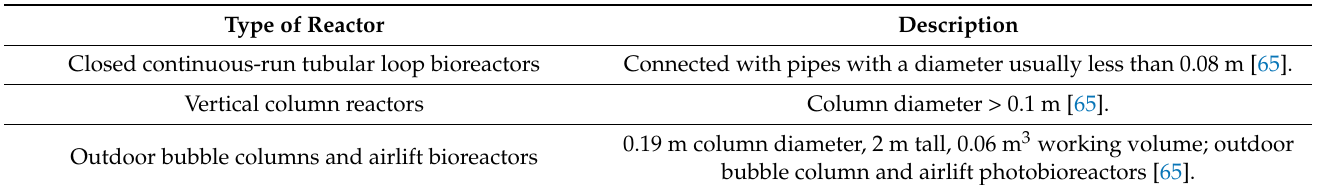
Table 6. Examples of the most popular photobioreactors used for the cultivation of microalgae. Type of Reactor Description Closed continuous-run tubular loop bioreactors Connected with pipes with a diameter usually less than 0.08 m [65]. Vertical column reactors Column diameter > 0.1 m